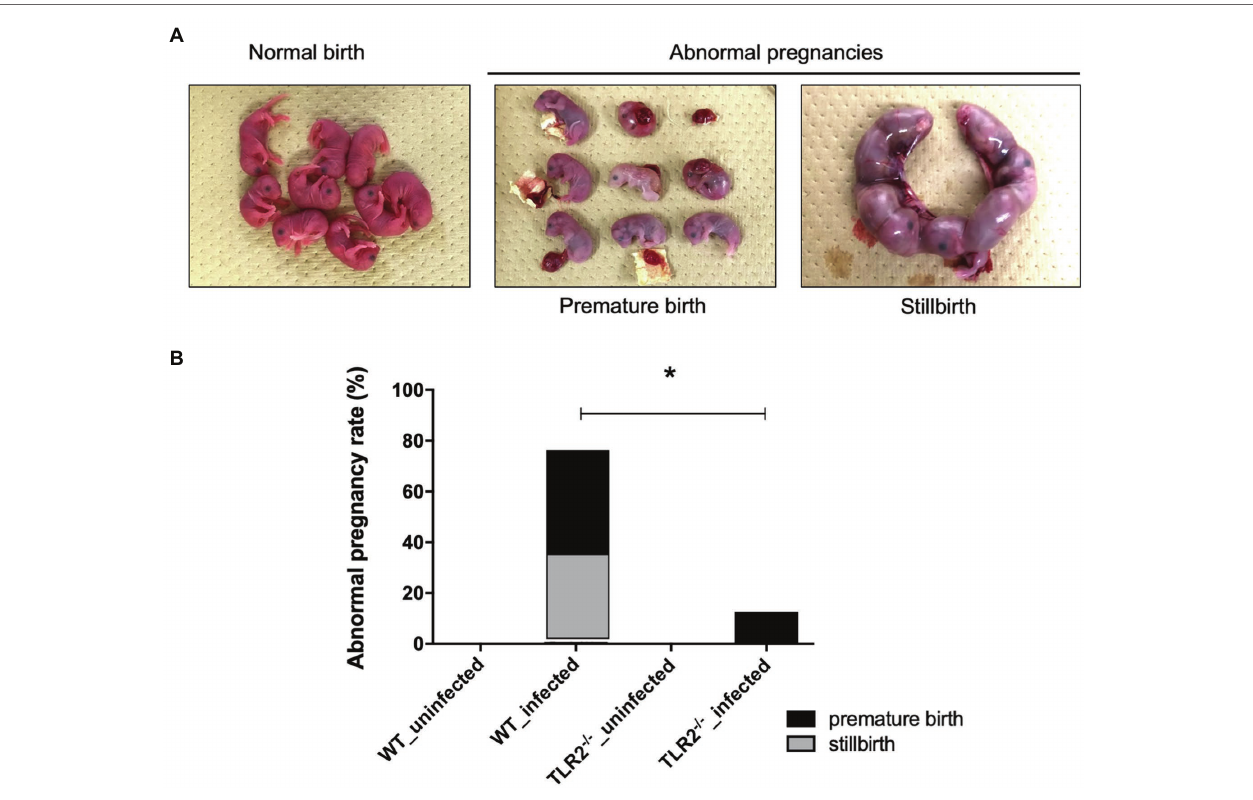
FIGURE 2 | Abnormal pregnancy rates in mice uninfected and infected with T. gondii . (A) Pups from normal births and dead pups from abnormal pregnancies, such as premature births and stillbirths. Representative photographs are shown. (B) Abnormal pregnancy rates in uninfected and infected mice. Abnormal pregnancy rates in each group are shown in a bar graph (uninfected wild-type [WT] mice, 0/12, 0%; infected WT mice, 9/12, 75%; uninfected TLR2 − / − mice, 0/5, 0%; infected TLR2 − / − mice, 1/8, 12.5%). Statistical analysis was performed with Fisher’s exact test. * p <